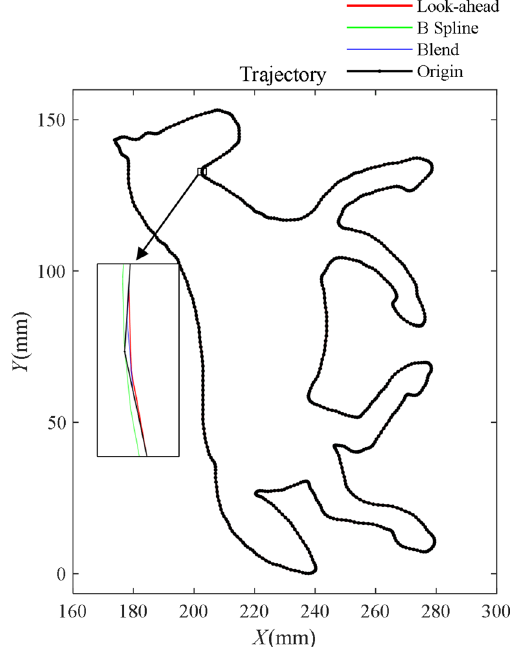
Figure 11 Comparison of trajectory paths plotted using the three